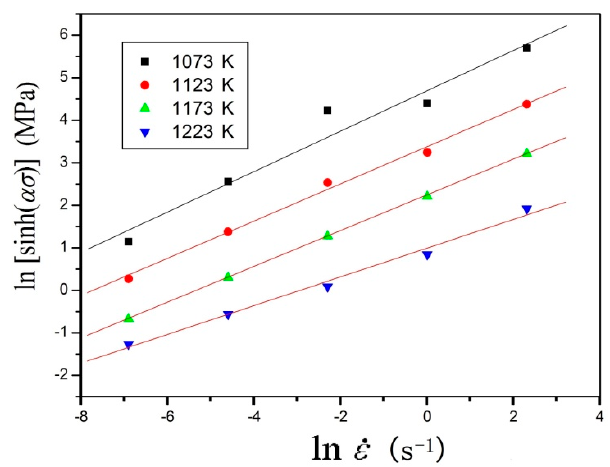
Figure 6. Evaluating the value of n by plotting ln[sinh( ασ )] versus ln έ .